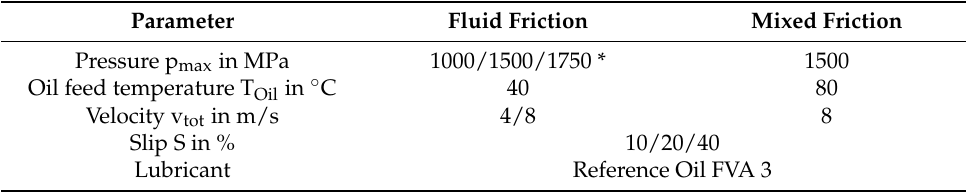
Table 6. Test conditions for slip.